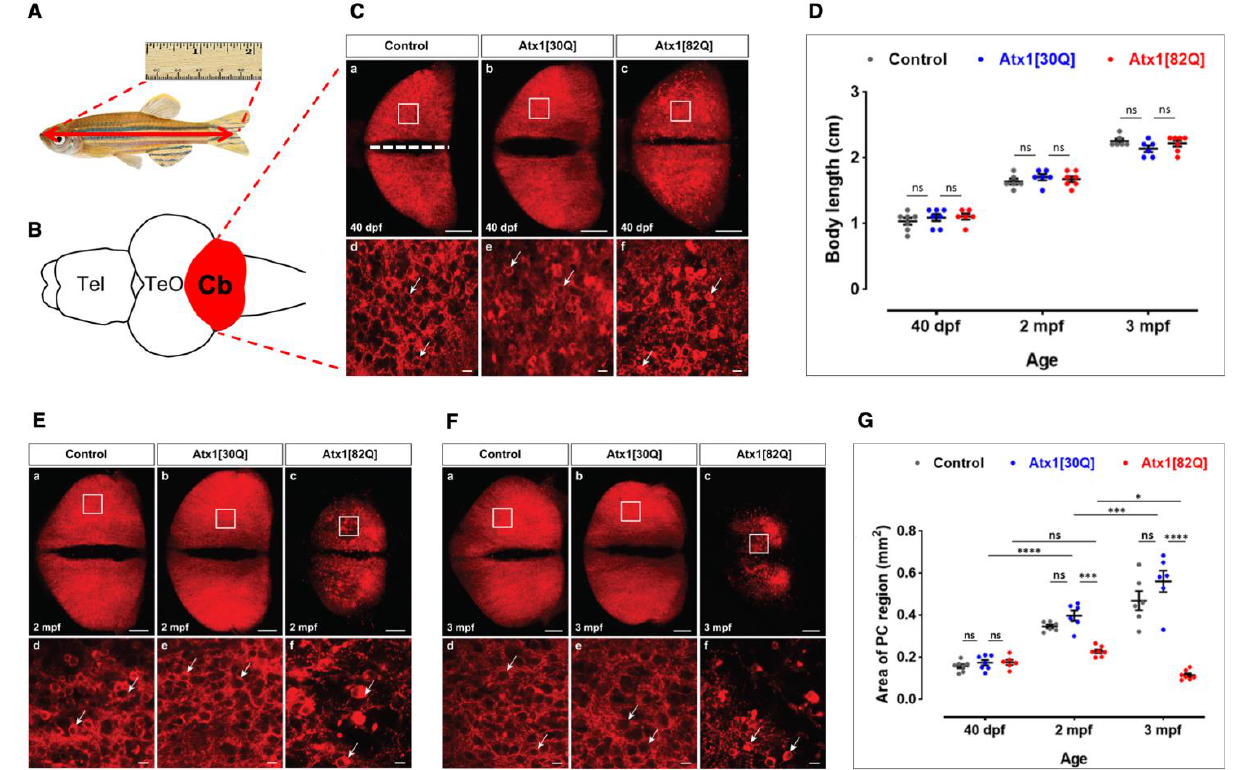
Figure 3. Progredient disintegration of PC layer in genetic model of SCA1 in zebrafish. ( A ) Schematic drawing of adult zebrafish to demonstrate measurement of body length form the anterior tip of the jaw until the caudal indentation of the tail fin. ( B ) The cerebellum in dissected brains from these specimens is easy to identify by the red fluorescent PC population forming a continuous layer of cells across the corpus cerebelli (dorsal view). ( C ) Maximum brightness projection of images stacks recorded by confocal microscopy from control ( a , d ), Atx1[30Q] ( b , e ), and Atx1[82Q] ( c , f ) expressing heterozygous carriers of the respective transgene at 40 dpf. Note speckles of brighter fluorescence suggestive of condensation and cellular shrinkage can be observed in the PC layer of Atx1[82Q] carriers not found in GAPmScarlet and Atx1[30Q] controls (compare white arrows). ( D ) Body length measurements reveal a similar overall growth rate to control ( n = 6), Atx1[30Q] ( n = 6), and Atx1[82Q] ( n = 6) fish. ( E ) Maximum brightness projection of image stacks recorded by confocal microscopy from control ( a , d ), Atx1[30Q] ( b , e ), and Atx1[82Q] ( c , f ) expressing heterozygous carriers of the respective transgene at two months of age and ( F ) three months of age, respectively. The area marked by a white rectangle is displayed at higher magnification below for each specimen, respectively. Compared to controls and Atx1[30Q], young adult Atx1[82Q] zebrafish at three months of age display a clear atrophy of their PC layer containing widespread fluorescent debris of degenerated PCs (Ff white arrows). ( G ) Quantification of area covered by fluorescent PCs, while in controls ( n = 6) and Atx1[30Q] carriers ( n = 6) a continuous age-dependent increase of the PC layer occurs, the expansion of the PC layer in Atx1[82Q] carriers ( n = 6) stalls. ( C , E , F ): dorsal views of corpus cerebelli, anterior to the left, scale bars: 100 µ m ( a – c ) or 10 µ m ( d – f ). The data in ( D , G ) are presented as mean ± SEM, * p < 0.05, *** p < 0.001 and **** p < 0.0001 according to two-way ANOVA with post hoc Tukey’s test. n = 7, 6, 6 in 40 dpf, 2 mpf (months postfertilization) and 3 mpf control groups, respectively. n = 7, 6, 6 in 40 dpf, 2 mpf, and 3 mpf Atx1[30Q] groups; and n = 6, 7, 7 in 40 dpf, 2 mpf, and 3 mpf Atx1[82Q] groups, respectively. Abbr.: Cb: cerebellum, PC: Purkinje cell, TeO: optic tectum, Tel: